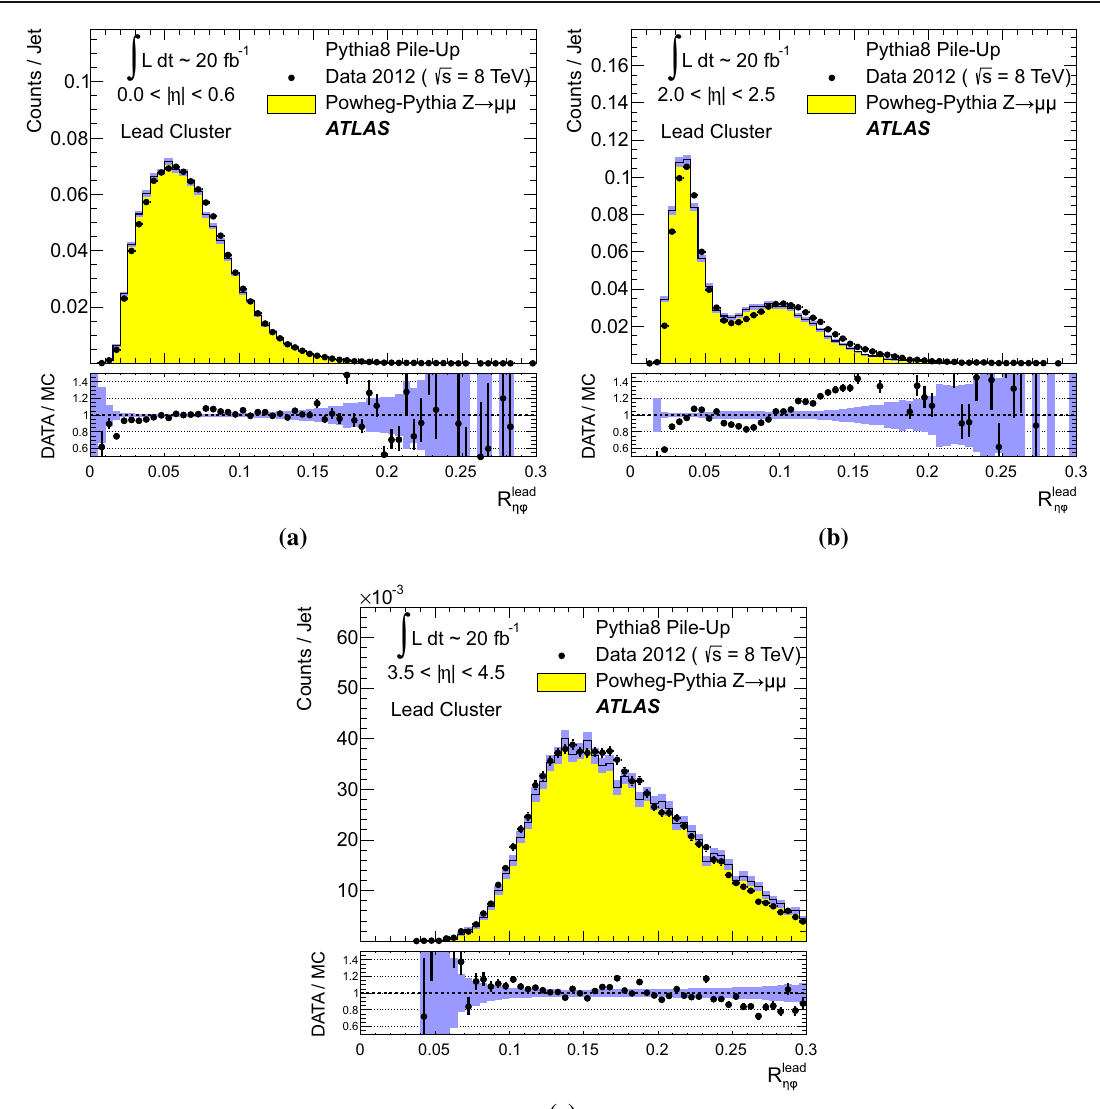
Fig. 43 The size R lead ηφ of the leading topo-cluster in (η,φ) space, mea- the c forwarddetectorregion(3 . 5 < | η | < 4 . 5)inATLAS.Theratiosof sured using Eq. (20), in anti- k t jetsreconstructed with R = 0 . 4 and with data to MC simulations are shown below the distributions. The shaded < 40GeV in Z → μμ events in 2012 data and bands shown for the distributions obtained from MC simulations indi- 30GeV < p LCW + JES T , jet MC simulations with fully simulated pile-up. Distributions are shown cate statistical uncertainties and the corresponding uncertainty bands in for jets in the a central ( | η | < 0 . 6), the b end-cap (2 . 0 < | η | < 2 . 5), and the ratio